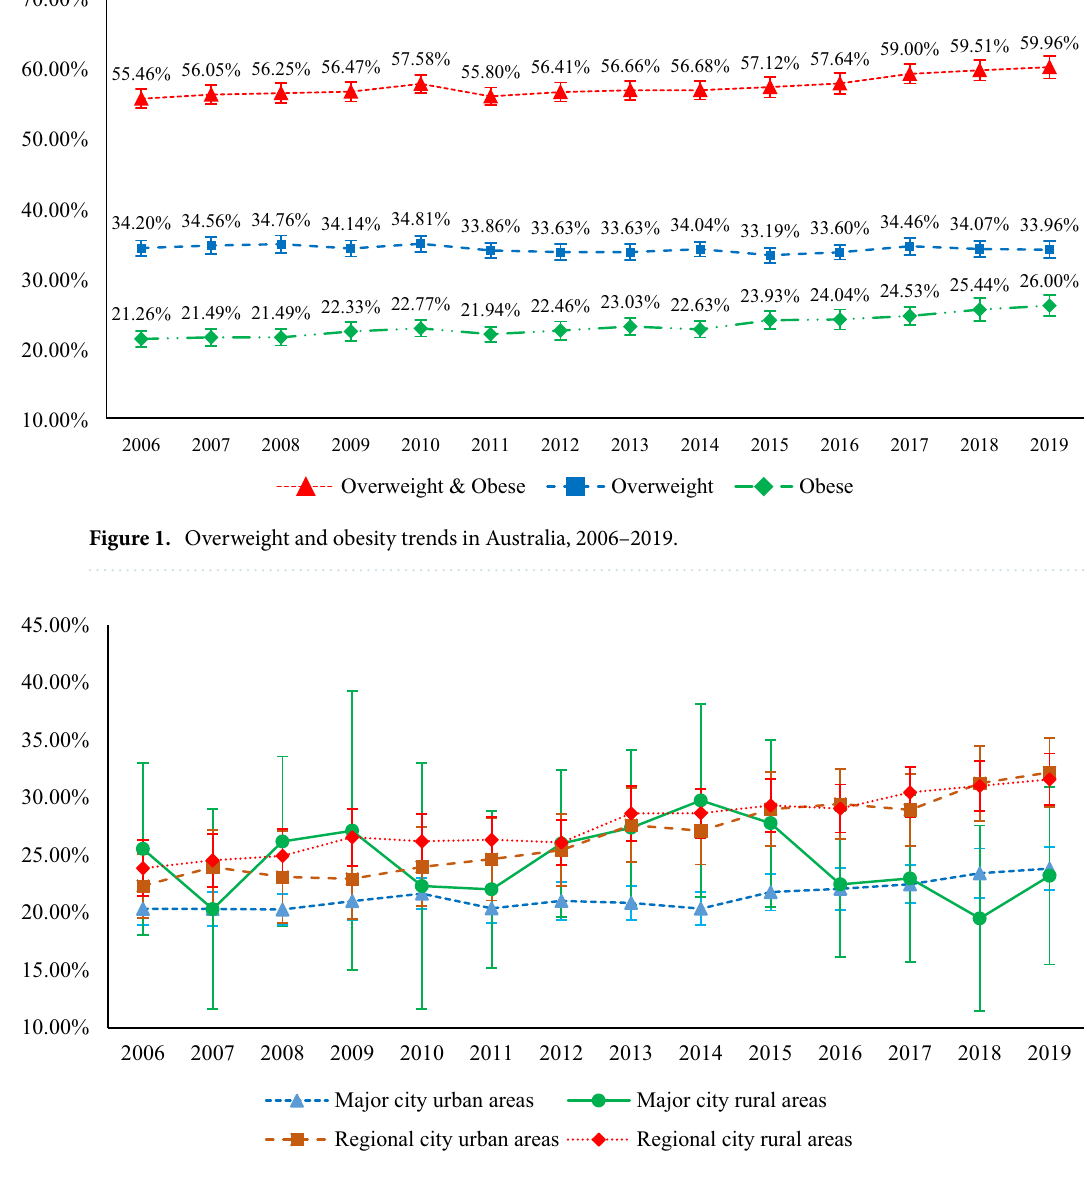
Figure 2. Trends in the prevalence of obesity by geographic remoteness in Australia,